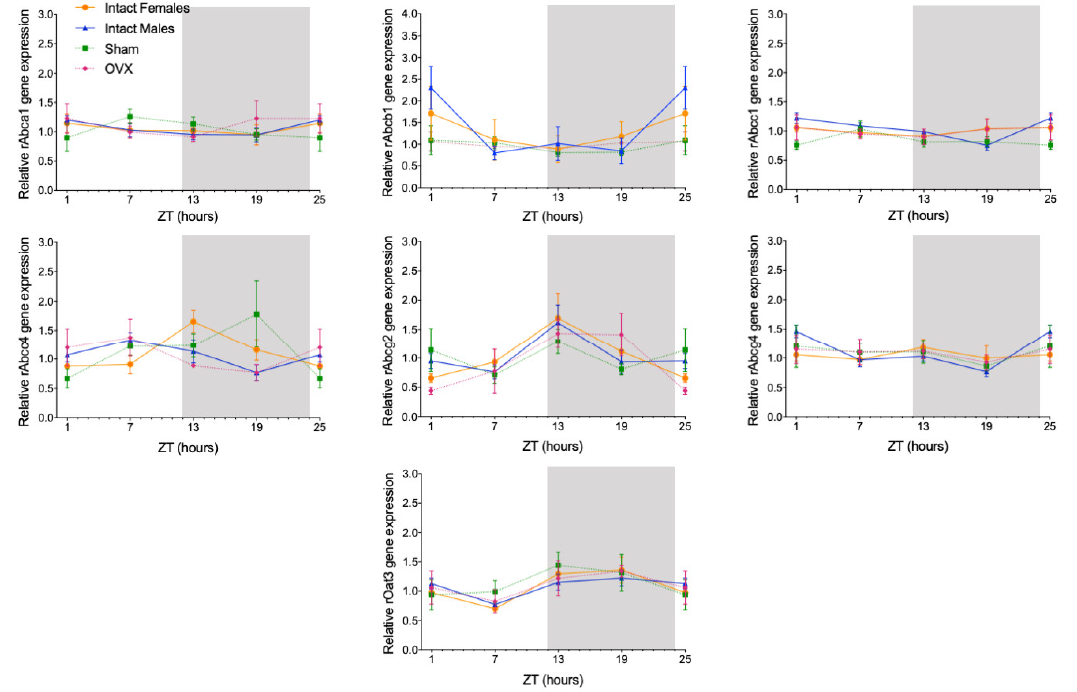
Figure 1. Circadian transcription profiles of membrane transporters in the CPs of intact males, intact females, ovariectomized (OVX), and sham-operated female rats (Sham). rAbca1, rAbcb1, rAbcc1, rAbcc4, rAbcg2, rAbcg4, and rOat3 mRNA circadian expression was analyzed. White and grey backgrounds represent the day and night periods, respectively. Panel shows the mean ± SEM transcript levels ( n = 3–6), and data from ZT1 and ZT25 are double plotted.